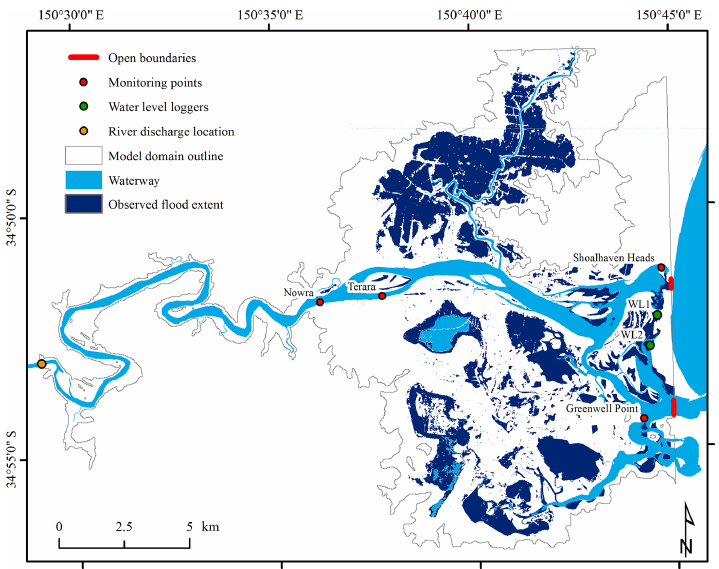
Figure 5. Map showing the hydrodynamic model domain (grey outline), open boundaries in Crookhaven Heads and Shoalhaven Heads (bold red lines), the river discharge location upstream (orange dot) and monitoring points corresponding to tidal gauges (red dots) and water level loggers (green dots). The flood extent of the June 2016 storm event in the lower Shoalhaven floodplain is indicated in dark blue.